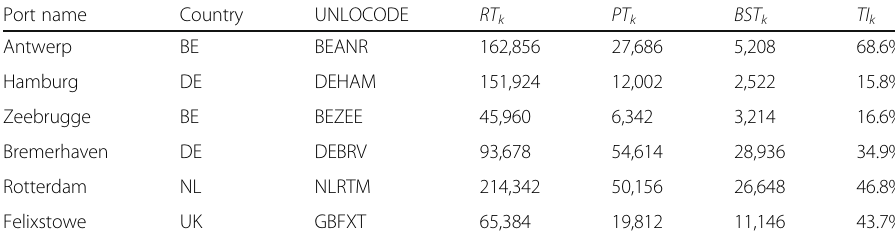
Table 3 Container ports in strategy sets I and